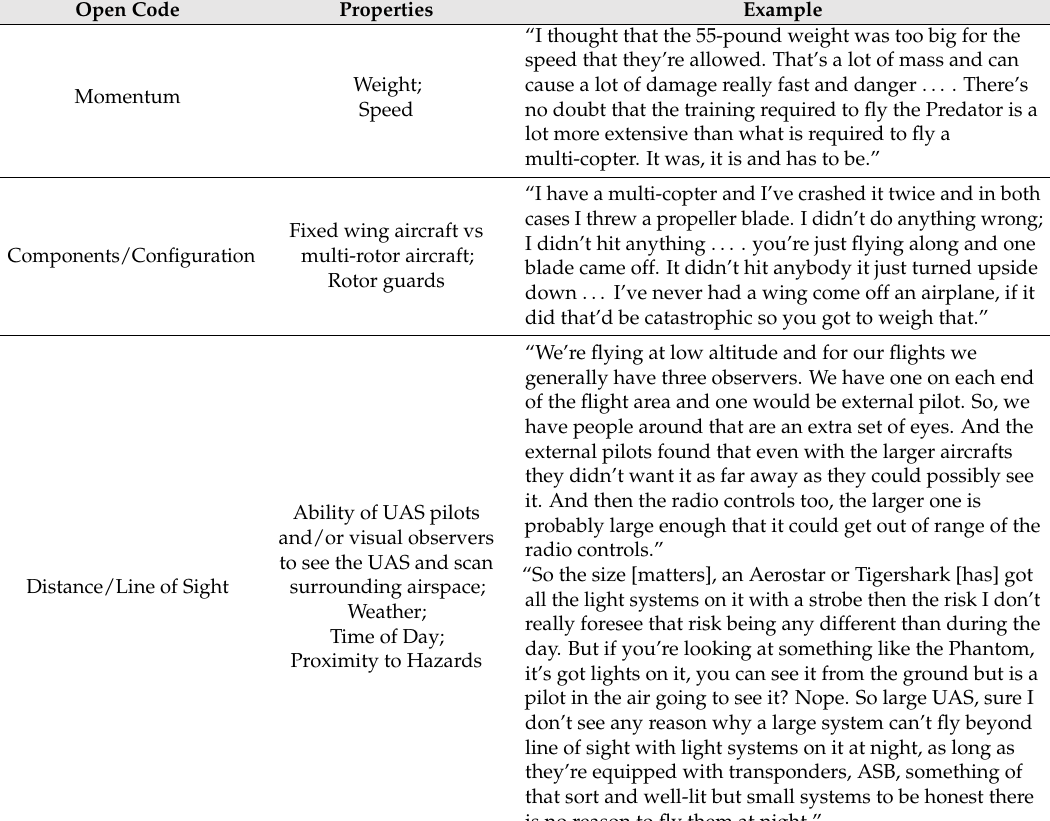
Table A6. Research Question: What aspects of UAS operations impact